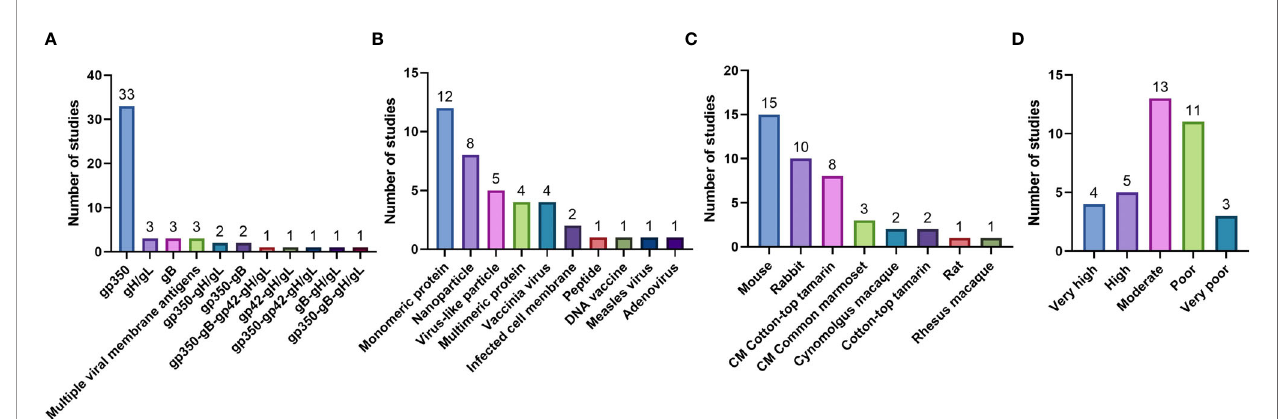
FIGURE 4 | Pre-clinical studies included in the systematic review, enumerated based on (A) Immunogen tested; (B) Type of vaccine delivery platform used; (C) Animal model used to test vaccine immunogenicity and ef fi cacy (CM = challenge model); and (D) Quality